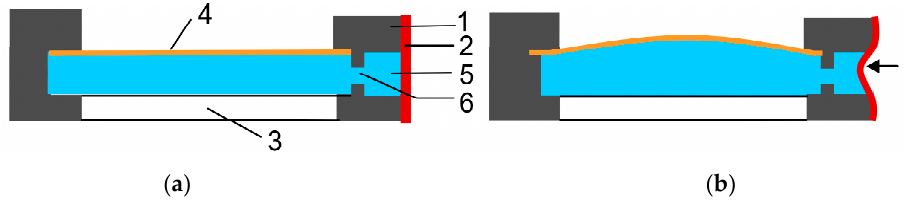
Figure 2. Side view of the liquid lens cell: ( a ) without and ( b ) with a convex lens profile. 1—annular sealing ring, 2—rubber membrane, 3—glass plate, 4—elastic membrane, 5—liquid, and 6—a hole. Reprinted with permission from [80]. Copyright 2006 Optical Society of America.